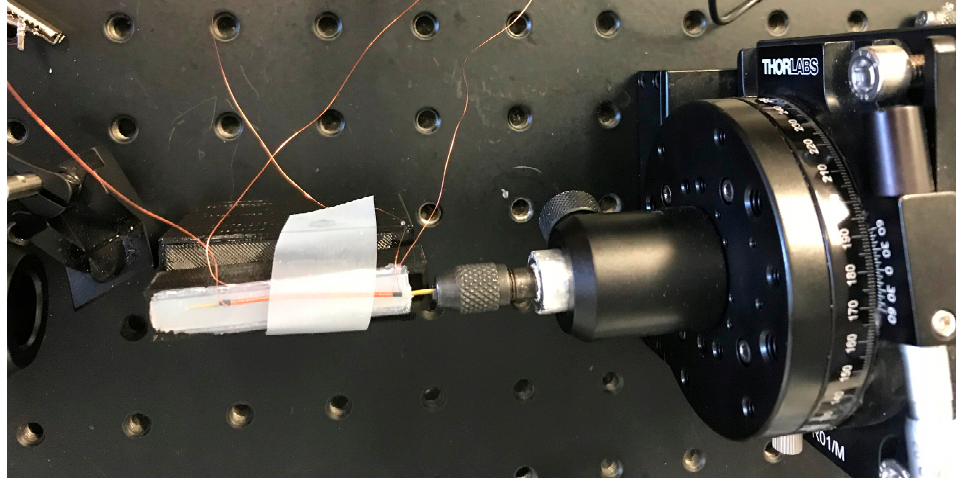
Figure 4. Holding amorphous wire from one end. (Method number one).